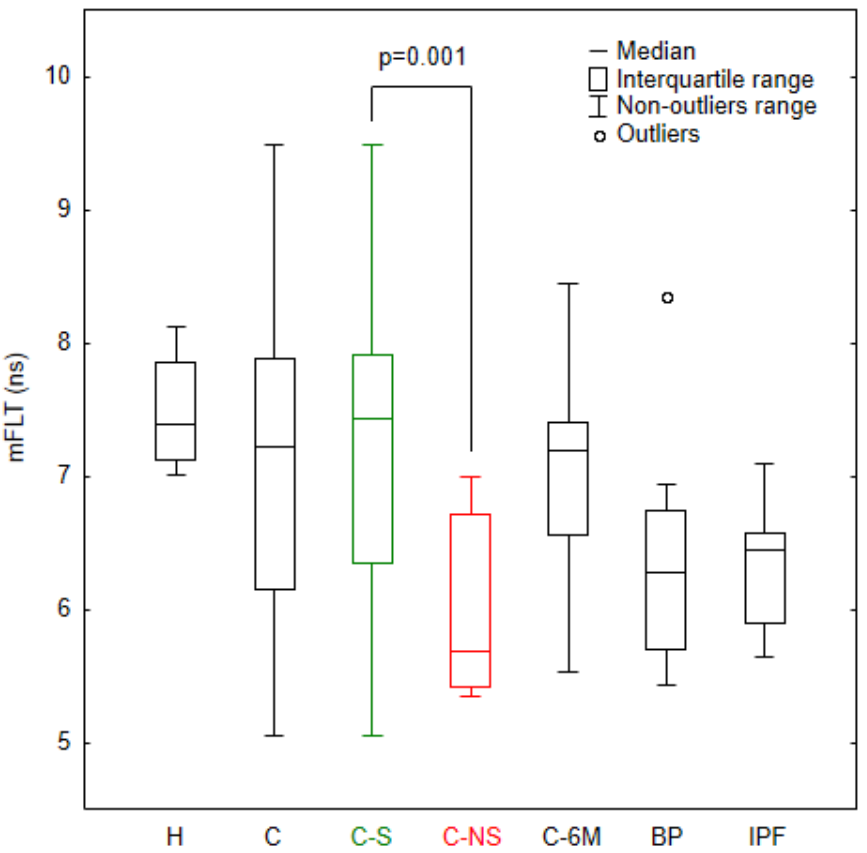
Figure 2. Mean fluorescence lifetime (mFLT) values for study groups. H—healthy, C—all COVID-19 patients, C-S—COVID-19 survivors, C-NS—COVID-19 non-survivors, C-6M—COVID-19 patients after 6 months from infection, BP—bacterial pneumonia patients without COVID-19, IPF—idiopathic pulmonary fibrosis patients. Data that were more than 1.5 interquartile range from this range were considered outliers.